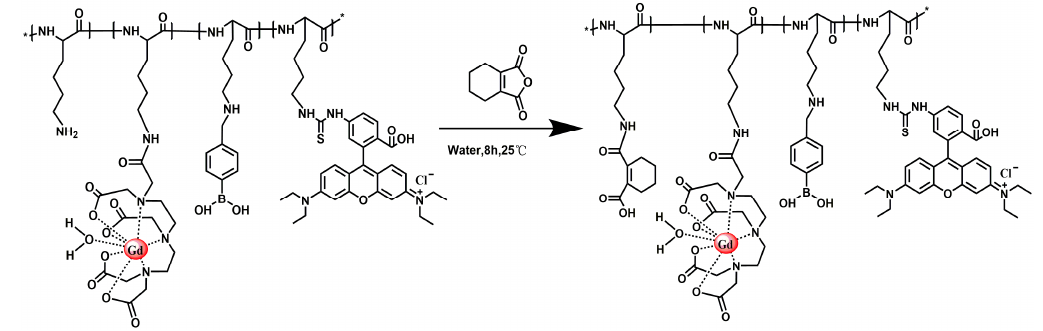
Figure 9. Synthesis route of PLL-B-DTPA-Rodamine-DCA.